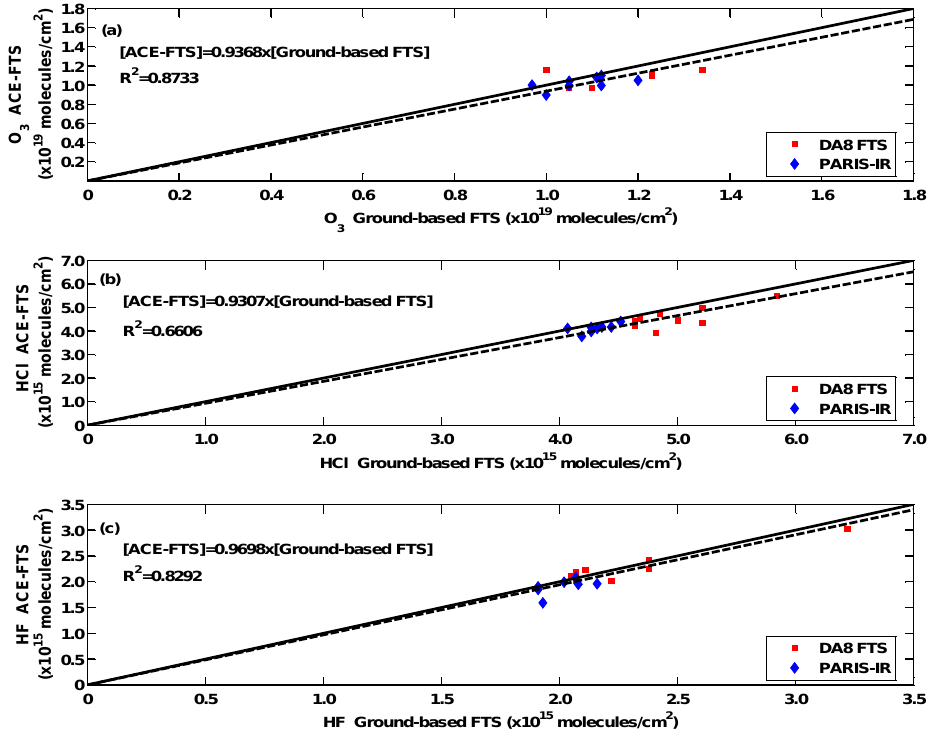
Fig. 6. Scatter plot of partial columns measured by ACE-FTS versus those observed by ground-based FTSs for (a) O 3 , (b) HCl, and (c) HF. In all figures, the dotted line shows the fitted correlation function between the two data sets being compared. Results from both the DA8 FTS and PARIS-IR were fit together in this calculation. The slope and R 2 for the comparisons are given on the figure. The solid line shows the one-to-one relationship for the